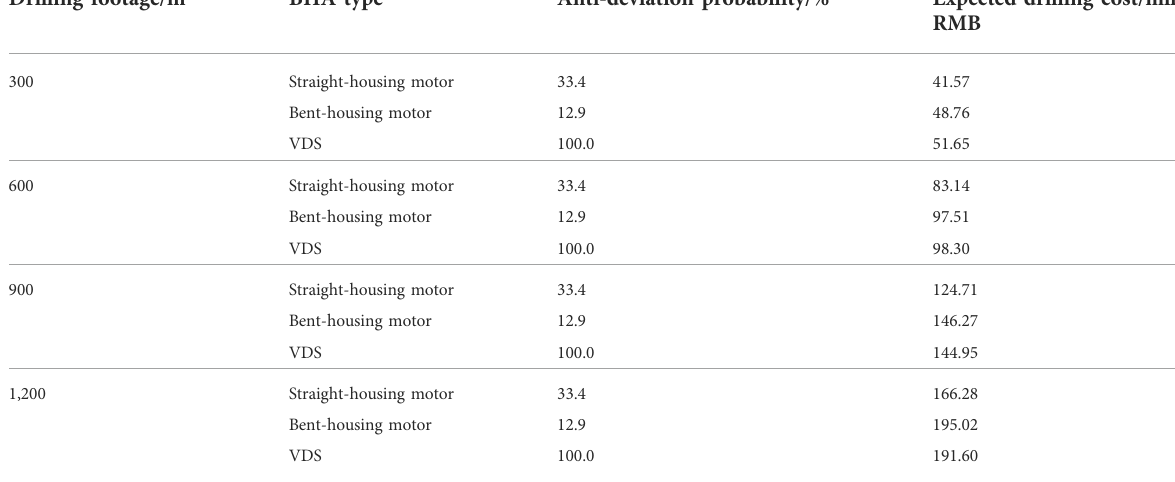
TABLE 1 Expected drilling cost of three vertical drilling